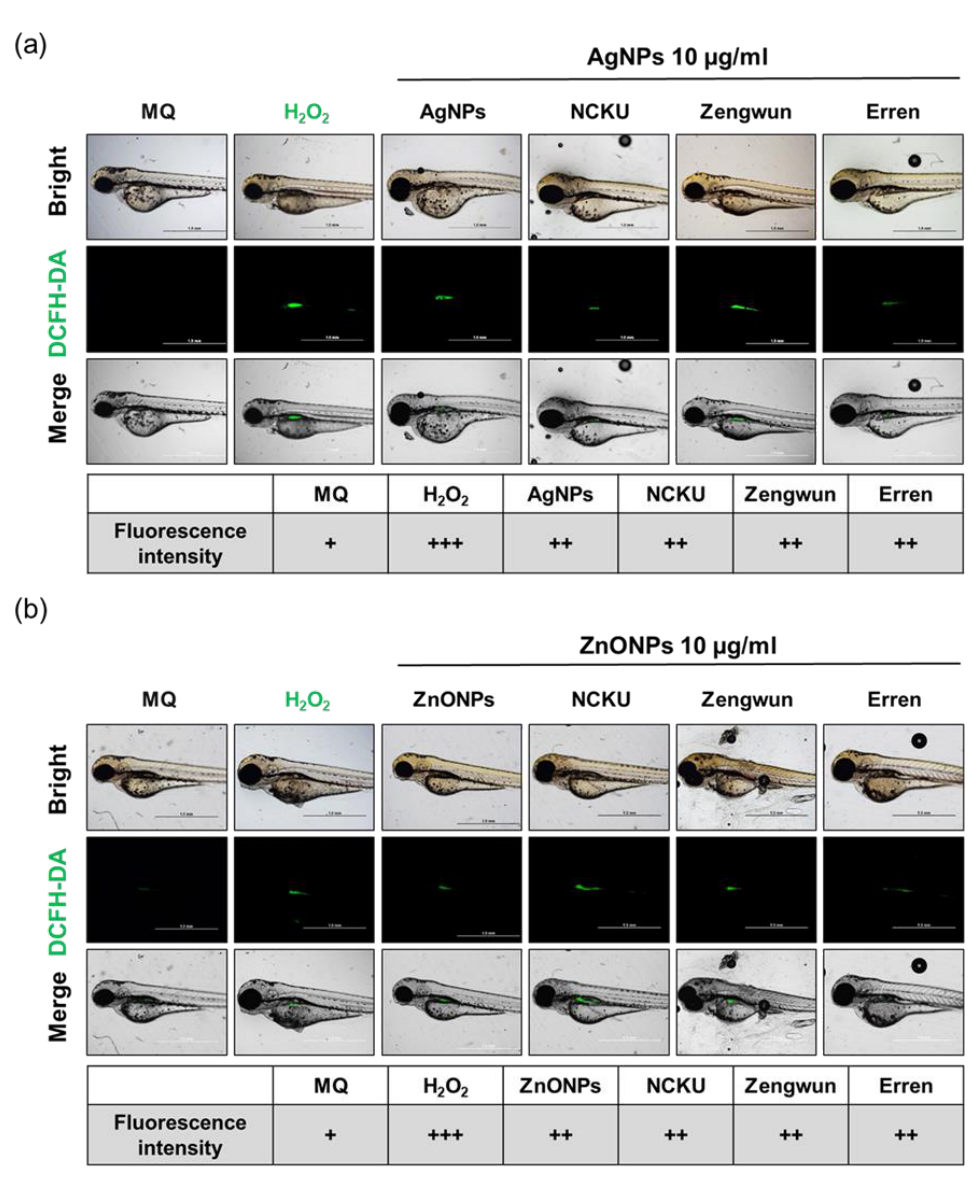
Figure 7. ROS generation induced by AgNPs and ZnONPs. Zebrafish embryos were exposed to natural water after passing through a 0.45 µm filter and then spiked with ( a ) AgNPs and ( b ) ZnONPs. After 72 hpf, zebrafish embryos were stained with DCFH-DA (green). The fluorescence intensity was assigned as + (weak), ++ (middle), and +++ (strong). The H 2 O 2 -positive control group showed ROS generation. Both AgNPs and ZnONPs spiked in natural water resulted in increased ROS signals. AgNPs, silver nanoparticles; ZnONPs, zinc oxide nanoparticles; DCFH-DA, dichlorodihydrofluorescein diacetate; ROS, reactive oxygen species.